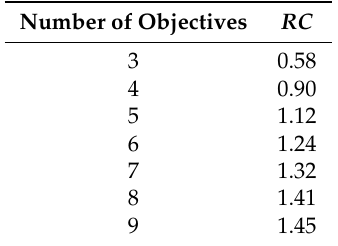
Table 2. Random consistency (RC) index